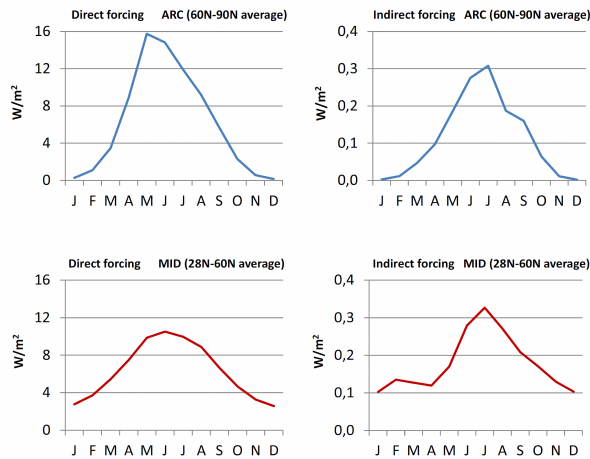
Fig. 4. Monthly mean direct forcing (left) and indirect forcing (right) at the TOA for the ARC-CONTROL 60–90 ◦ N average (top) and the MID-CONTROL 28–60 ◦ N average (bottom). All units in Wm − 2